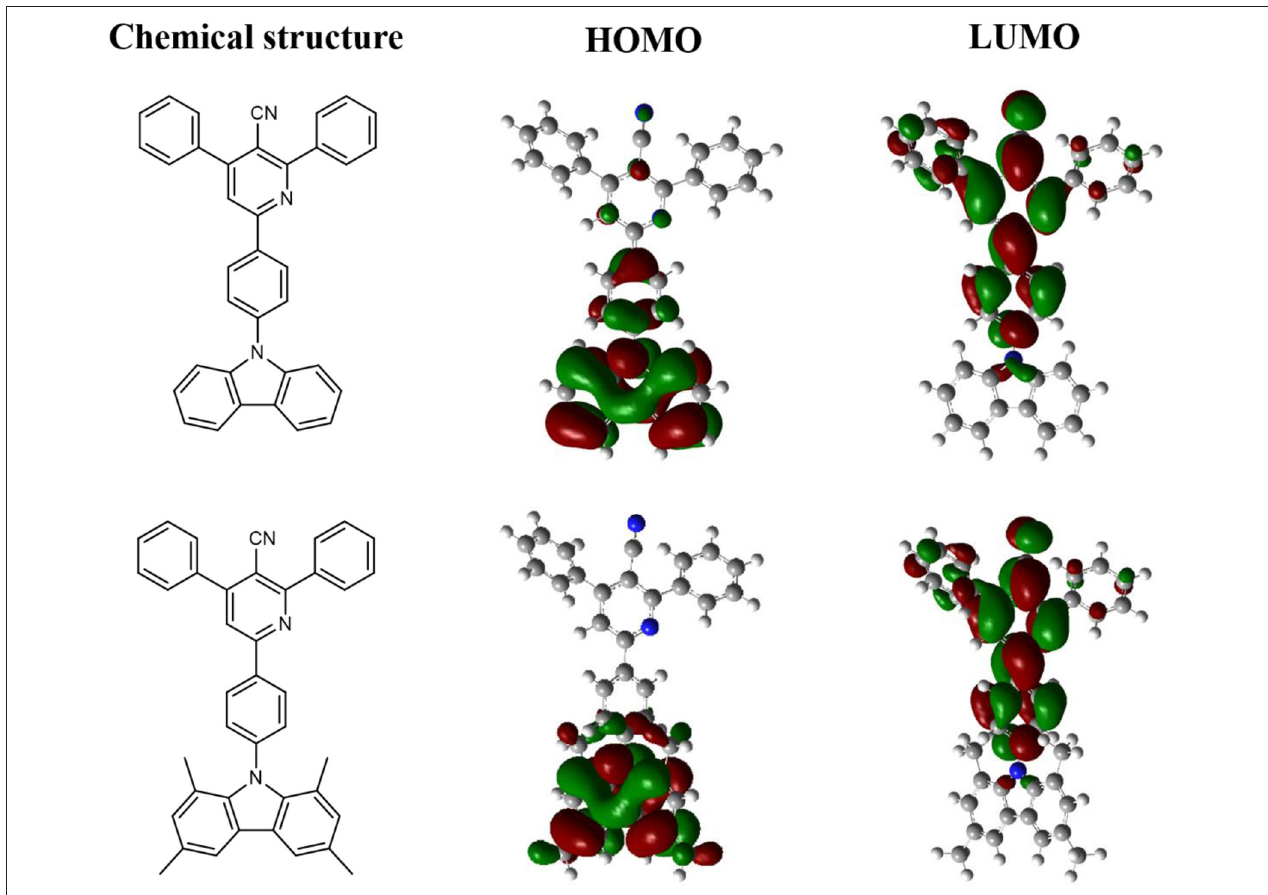
FIGURE 1 | Chemical structures, HOMO and LUMO distributions of CzPN and tMCzPN.